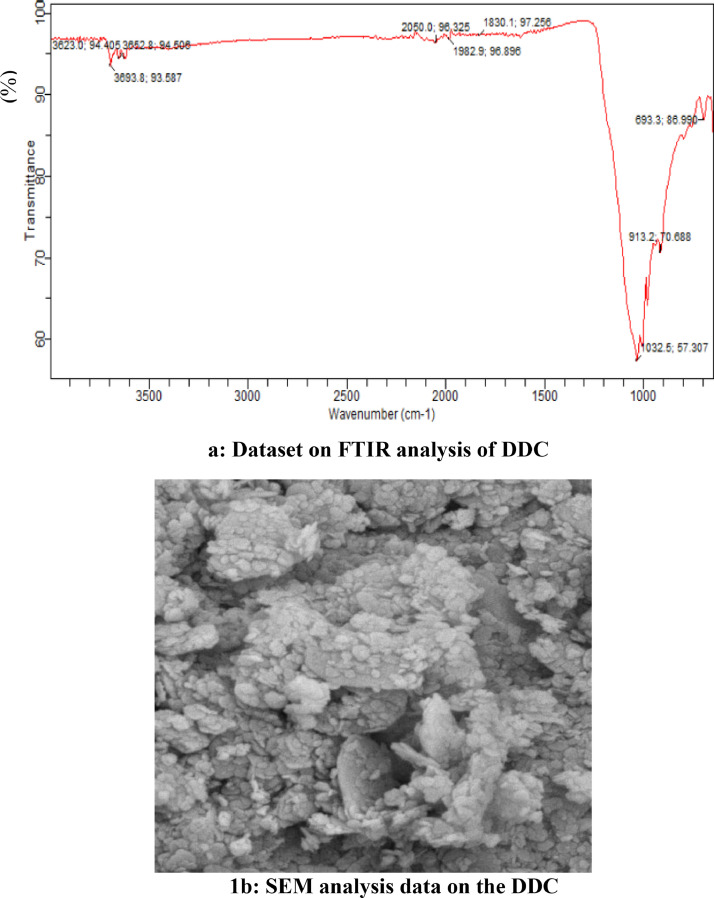
a: Dataset on FTIR analysis of DDC, Fig. 1b: SEM analysis data on the DDC.